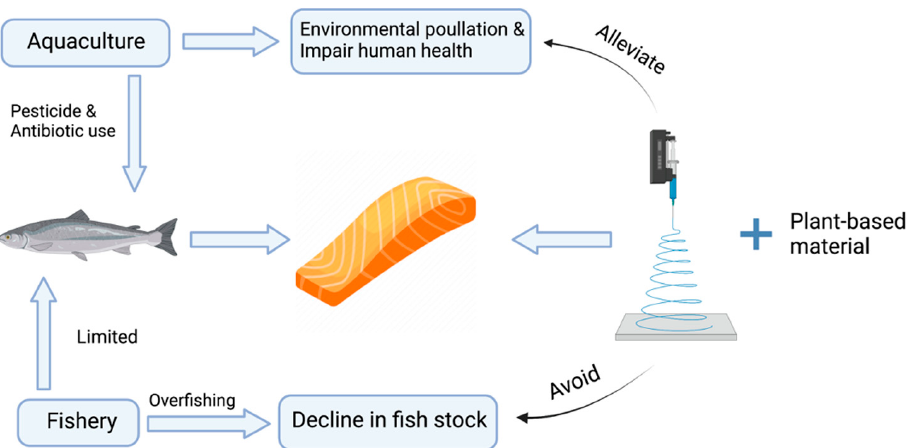
Figure 1. Rationale for developing plant-based fish analogues and the negative impact of fishery and aquaculture.